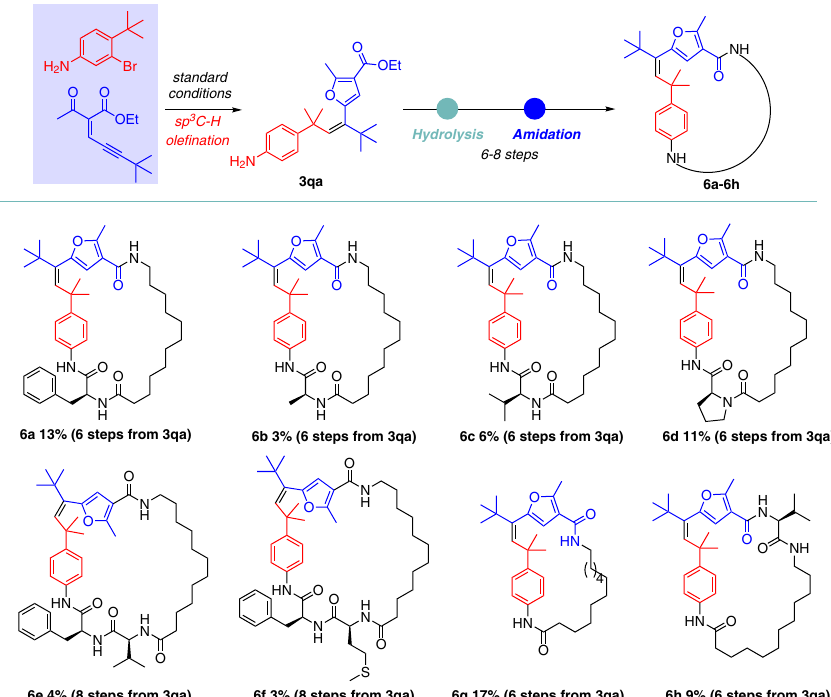
Fig. 5 Construction of macrolactams using polysubstituted alkenes and natural or unnatural amino acids as building blocks. Reaction conditions: please see page 7 – 14 of Supplementary